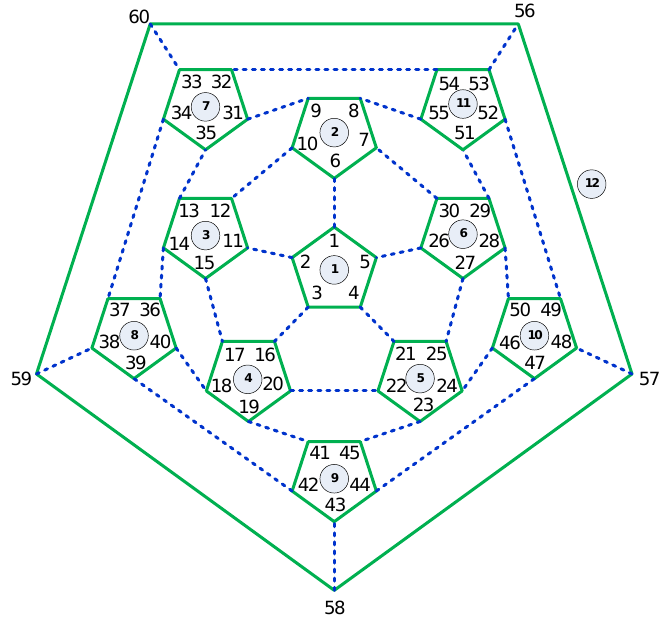
Figure 17. Connectivity of the 3D-truncated tetrahedron tensegrity in which the blue dotted lines denote vertical cables, and others represent edge